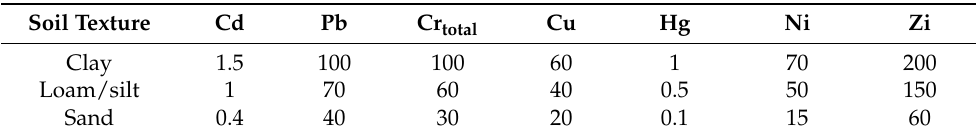
Table 8. Precautionary values for metals (in mg kg − 1 dry matter, fine soil, and aqua regia digestion) (BBodSchV, Annex